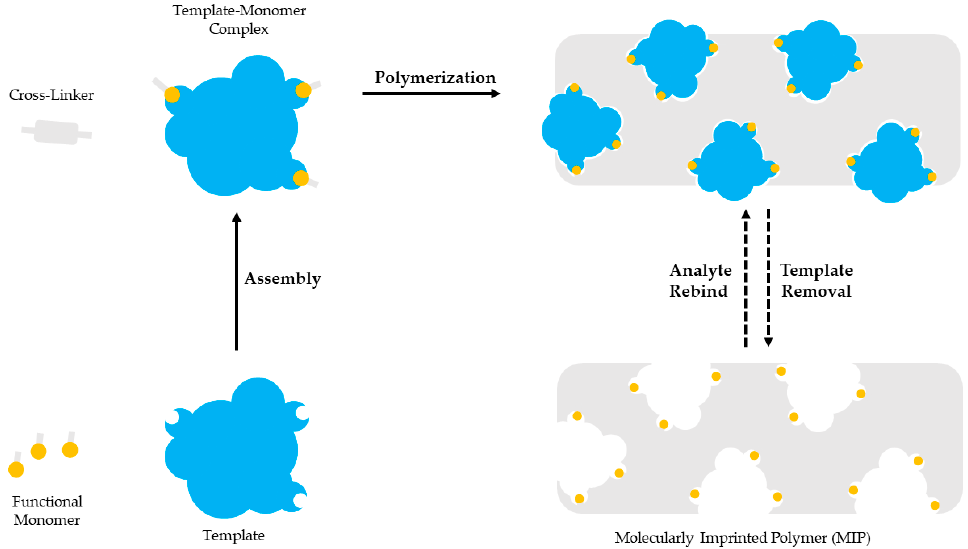
Figure 1. The template molecule and the functional monomer interact. The template-monomer complexes and a cross-linker polymerize. The template molecule is removed to provide a polymer with imprinted sites.